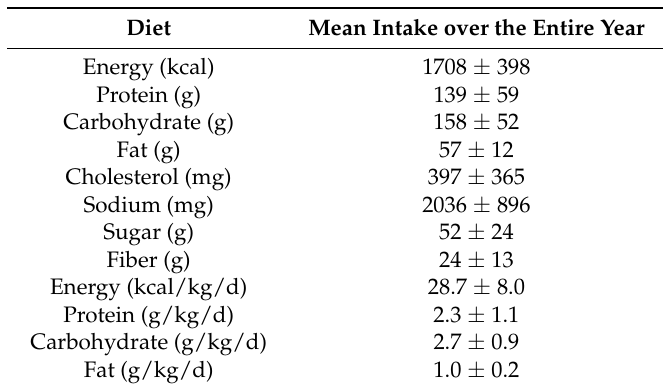
Table 1. Dietary